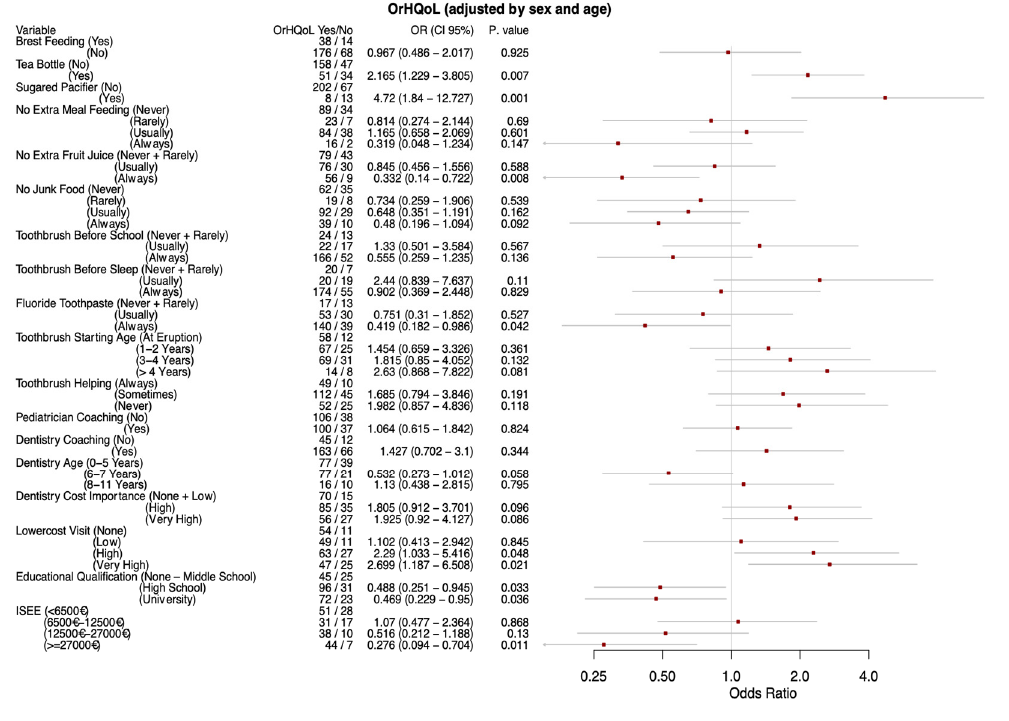
Figure 2. Multivariate unconditional logistic regression analysis for the outcome OHRQoL.